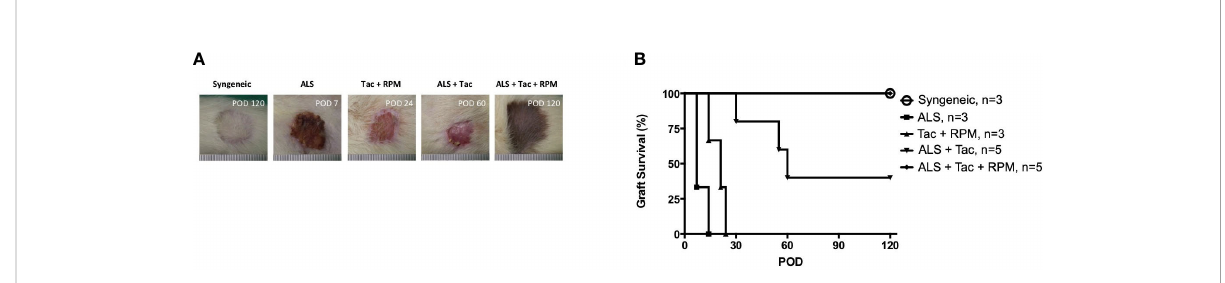
FIGURE 2 Long-term VBM transplant acceptance was achieved with antilymphocyte serum combined with tacrolimus and rapamycin. (A) Macroscopic photograph of allograft in each group. (B) Kaplan – Meier survival analysis of allograft survival of groups that received VBM allograft only. Syngeneic vs. ALS + Tac + RPM, p = 0.999; ALS vs. ALS + Tac + RPM, p = 0.005; Syngeneic vs. ALS + Tac + RPM, p = 0.005; ALS + Tac vs. ALS + Tac + RPM, p =